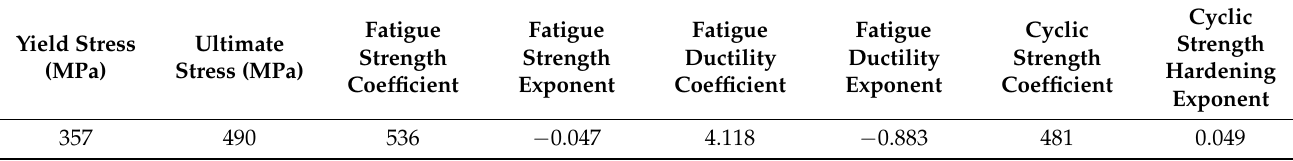
Table 1. Parameters of HF50_10